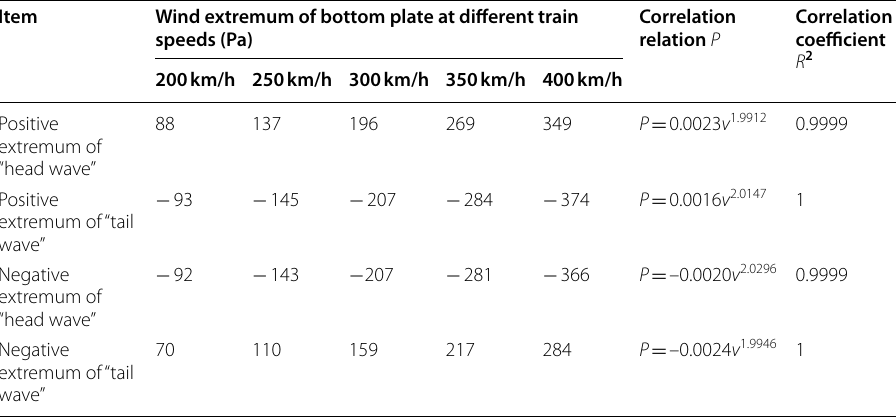
Table 1 Positive extremum and negative extremum of “head wave” and “tail wave” of bottom plate at different train speeds